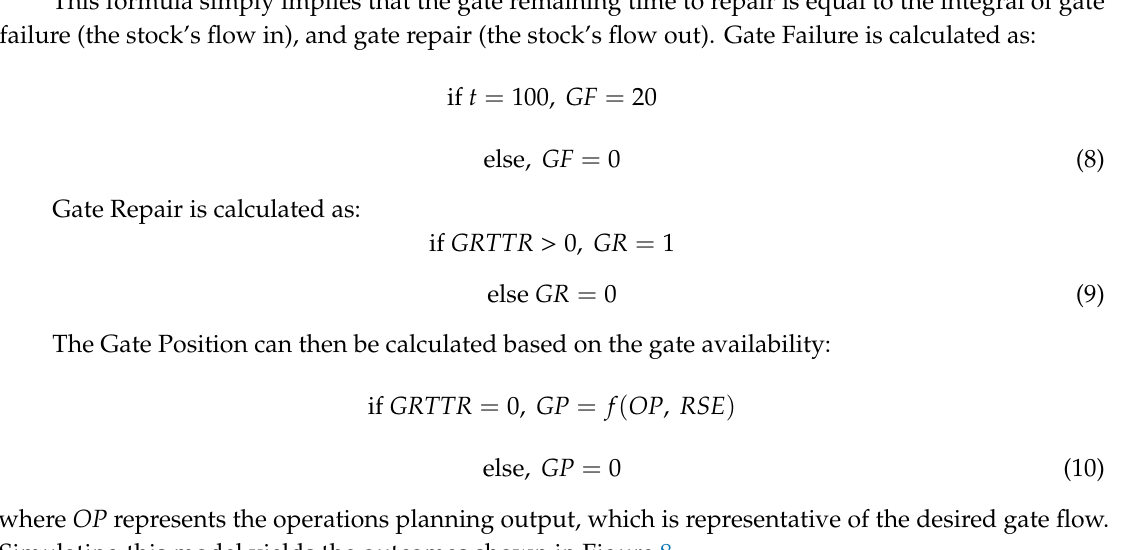
Figure 7. Simple system with gate and weir, with operations planning and gate failures implemented.